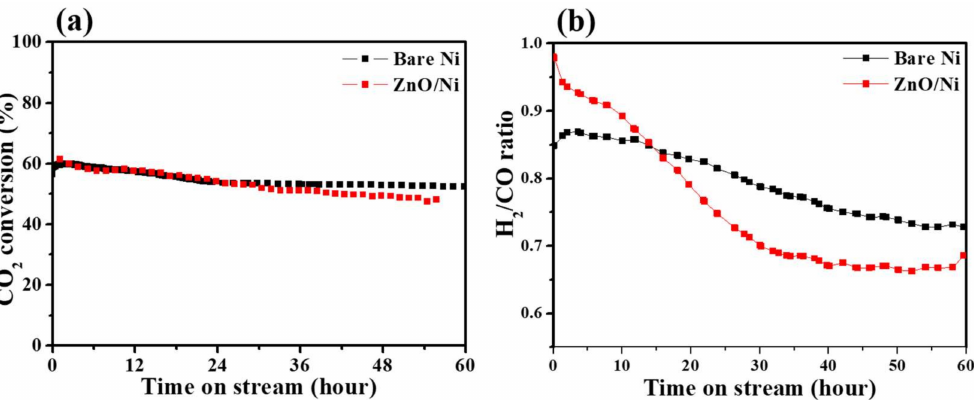
Figure 5. ( a ) CO 2 conversion and ( b ) ratio of H 2 to CO, which are products of the DRM reaction, for bare Ni and ZnO-wrapped Ni. The DRM reactions were carried out at 800 ◦ C under atmospheric conditions with a constant flow of the gas mixture (CH 4 :CO 2 = 1:1, total flow rate of 20